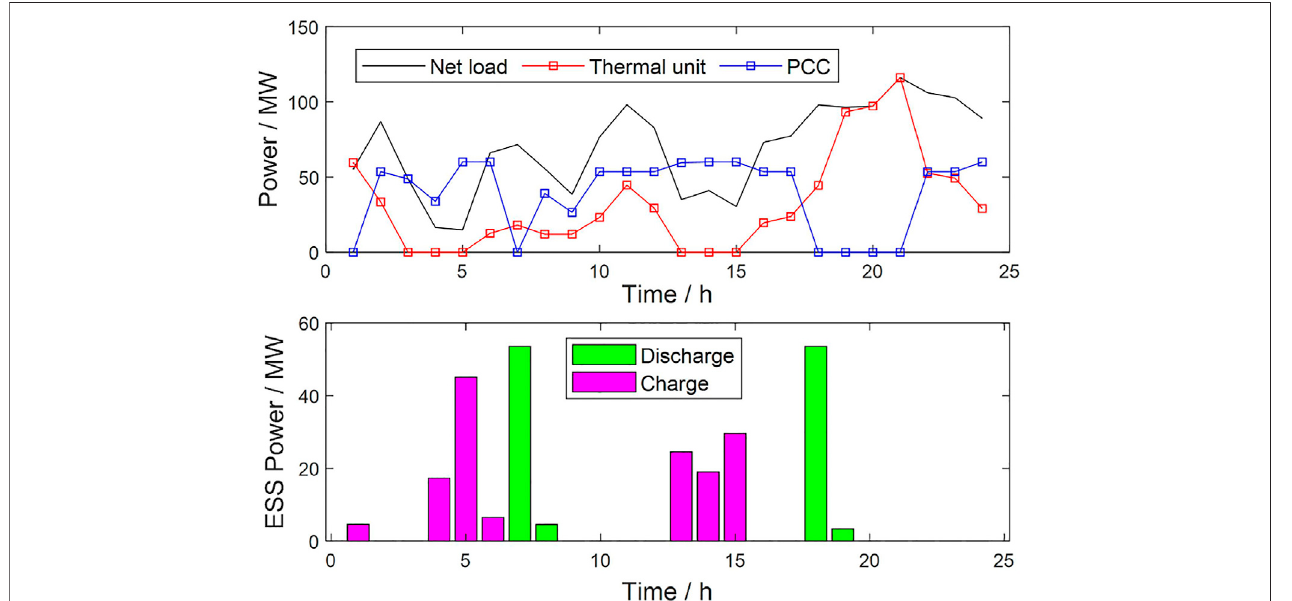
FIGURE 4 | Day-ahead scheduling